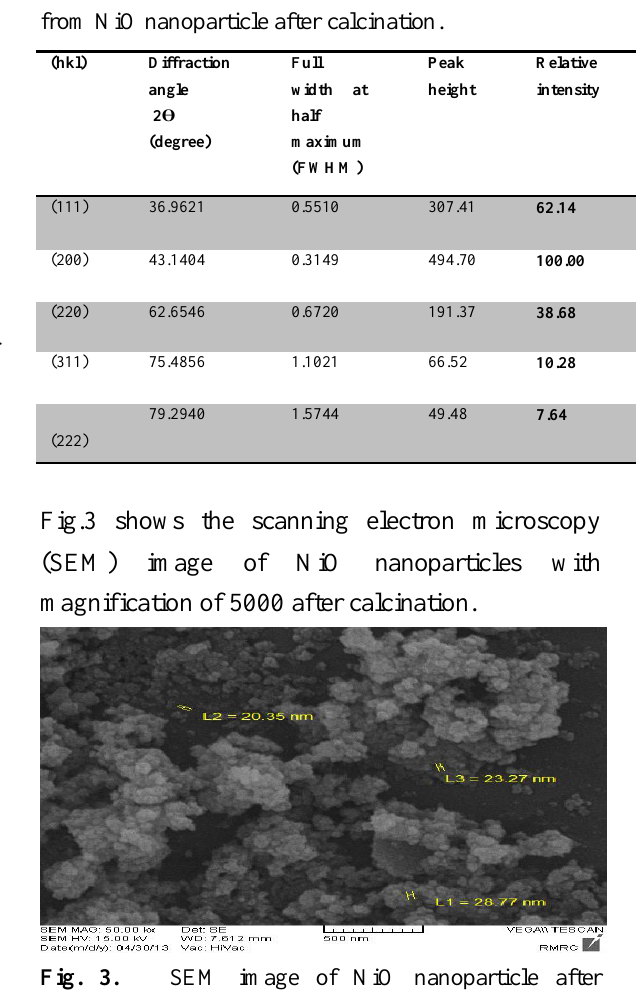
Fig. 3. SEM image of NiO nanoparticle after calcinations. The results indicate that particles are in are spherical shape and nanoclusters due to agglomeration process. The average size of the NiO nanoparticle observed from SEM images is 24